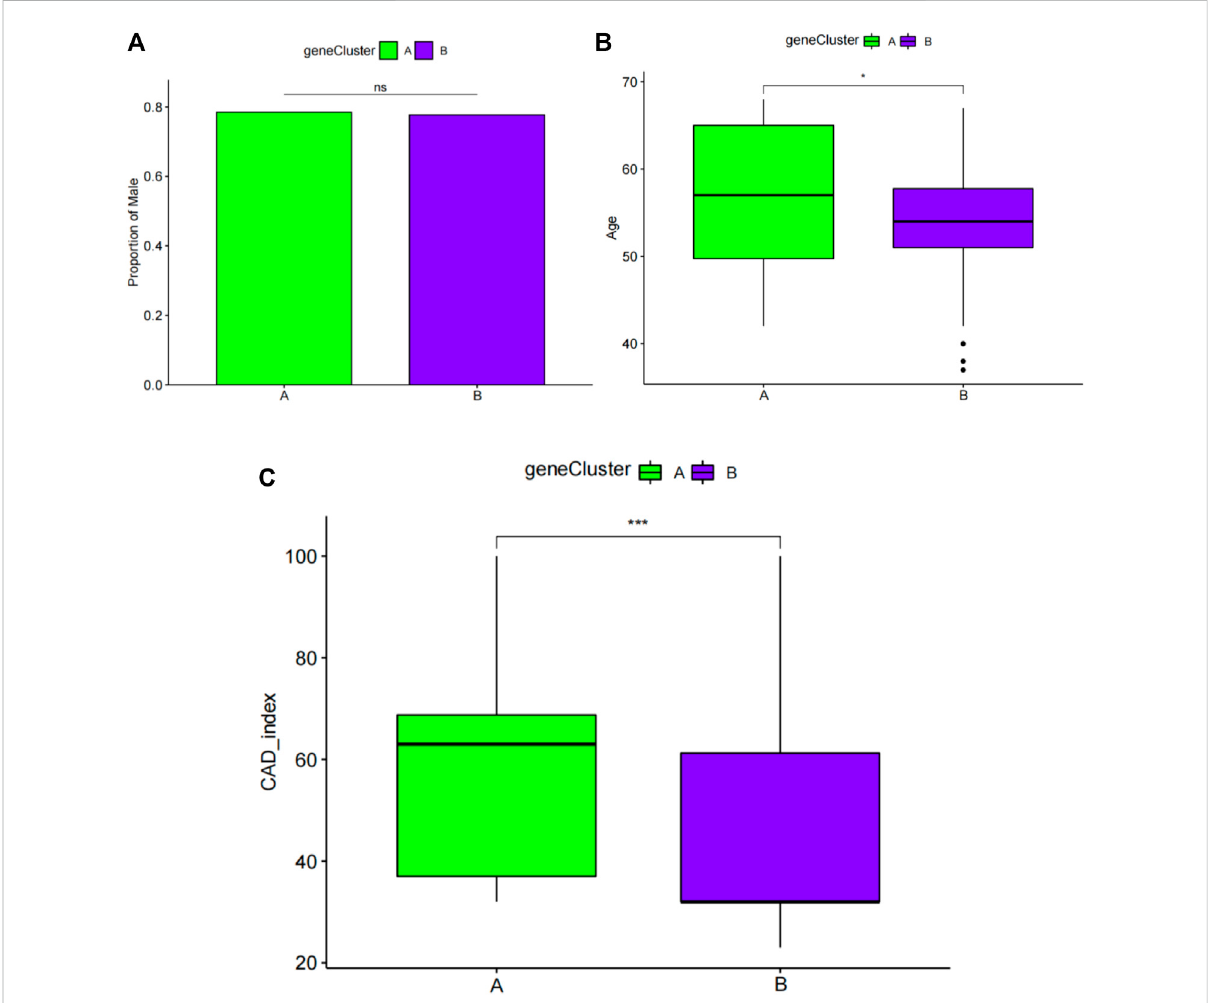
FIGURE 11 Pairwise comparisons of clinical characteristics between gene cluster A and gene cluster B. (A) The proportion of men in each subgroup is represented by the bar plot. Boxplots (B,C) display ages and CAD indices for the subgroups. CAD: coronary artery disease. * p < 0.05, ** p < 0.01, and *** p <